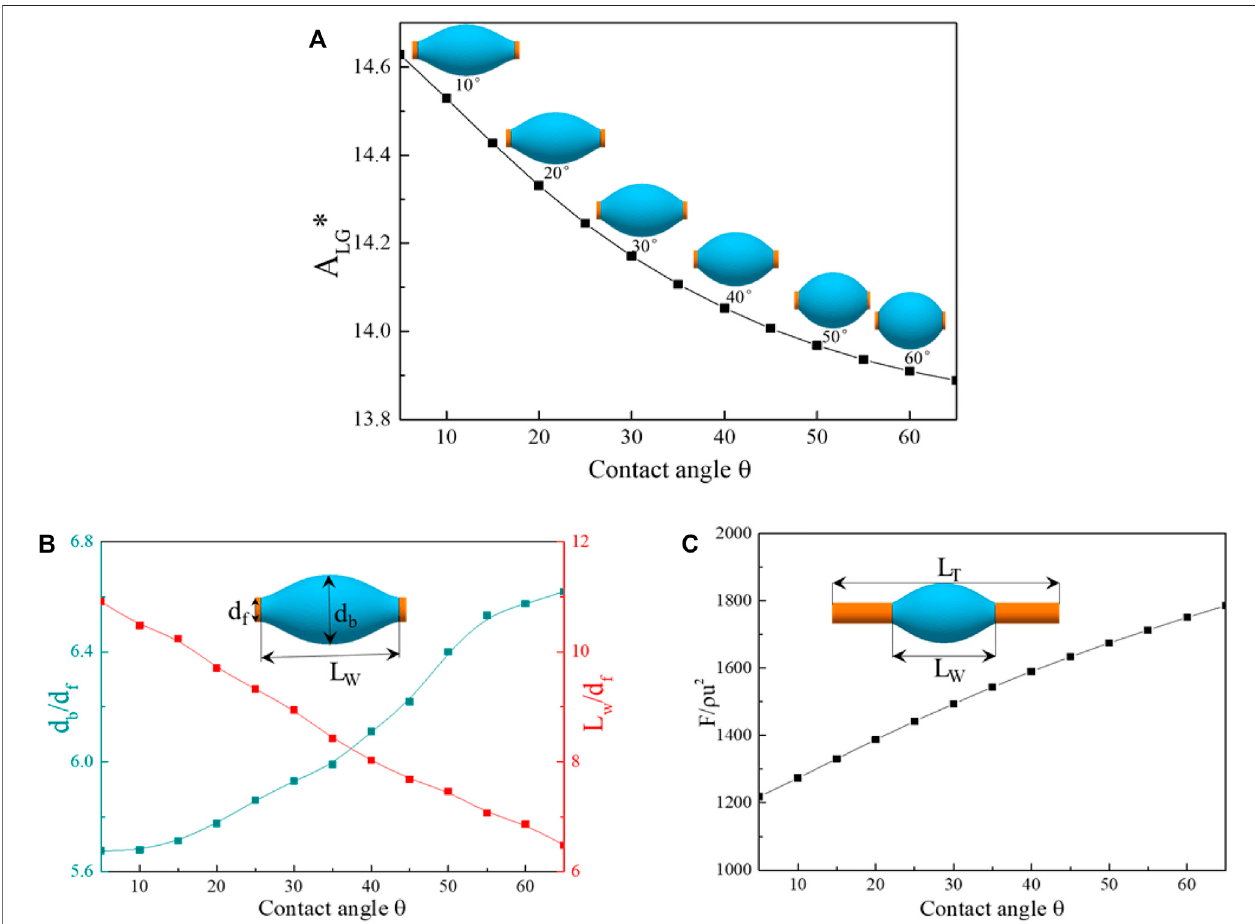
FIGURE2 |(A) Variation ofdimensionless freesurface with contact angle. (B) Change ofdimensionless maximum diameter and wetting length withcontact angle. (C) In fl uence of contact angle on dimensionless air resistance of barrel-shaped droplet.